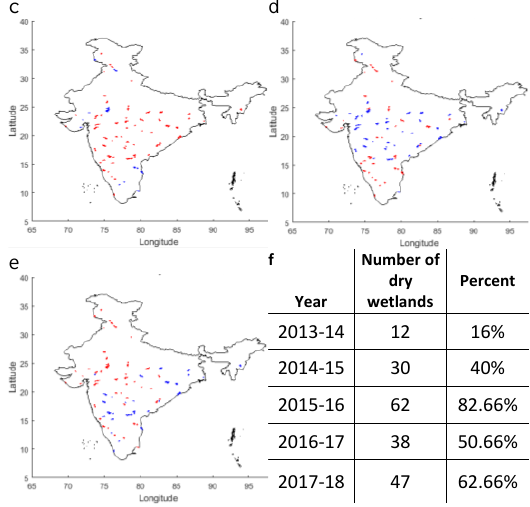
Figure 2: (a-e) represent annual deviation from 5 year mean storage area for the 75 wetlands. Wetlands with positive deviation are shown in blue whereas those with negative deviation (dry wetlands) are shown by Red colour. (f) summarises the number of wetlands that have shown negative deviation as a percentage of total wetlands.